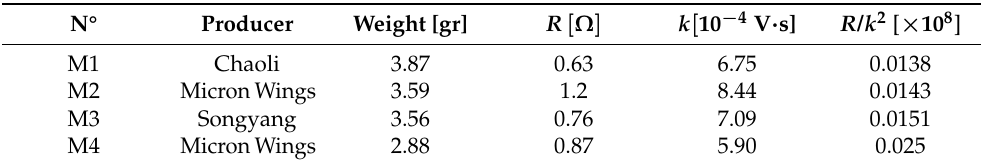
Table 3. Characteristics of the motors considered in this study.